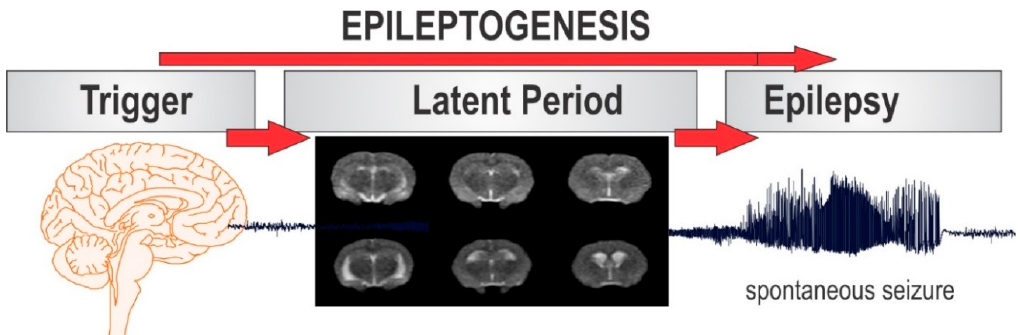
Figure 2. The cellular and molecular abnormalities that are observed during the latent period as predictive biomarkers of epileptogenesis. Various modalities as putative biomarkers of epileptogenesis include biochemical, neuroimaging, electrophysiological markers. Neuroimaging biomarkers can be developed based on cellular and mechanistic changes, such as neurodegeneration, astrocyte activation, microglial activation, vascular remodeling, axonal sprouting, oxidative stress and calcium deposition.